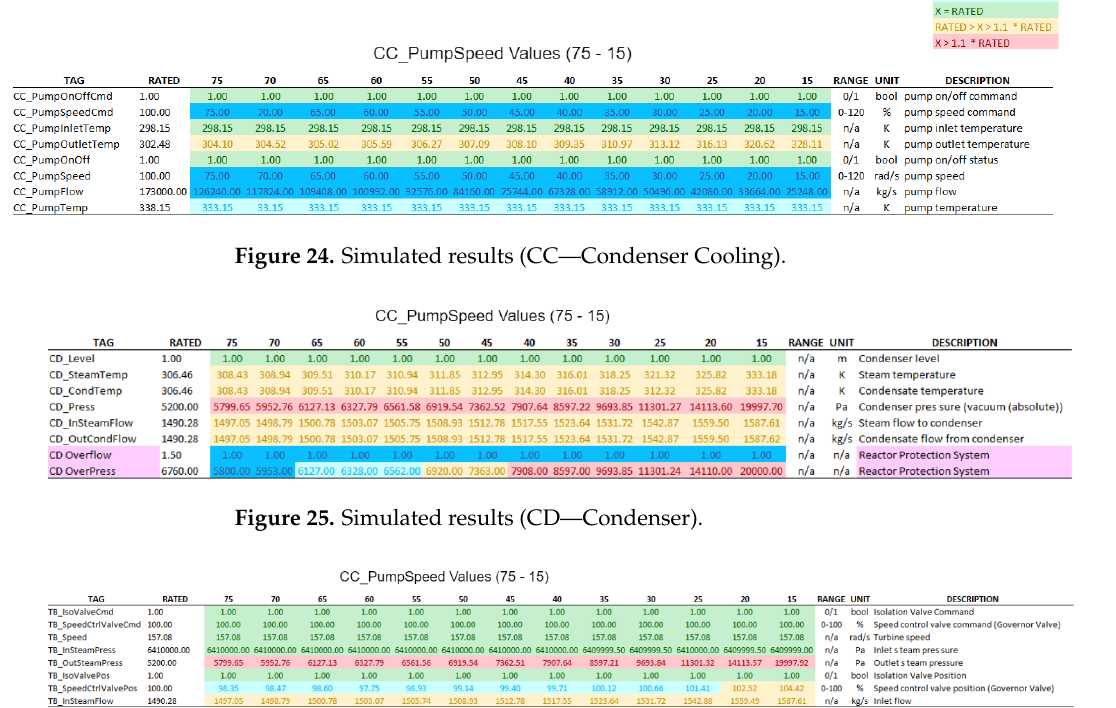
Figure 26. Simulated results (TB–Turbine).